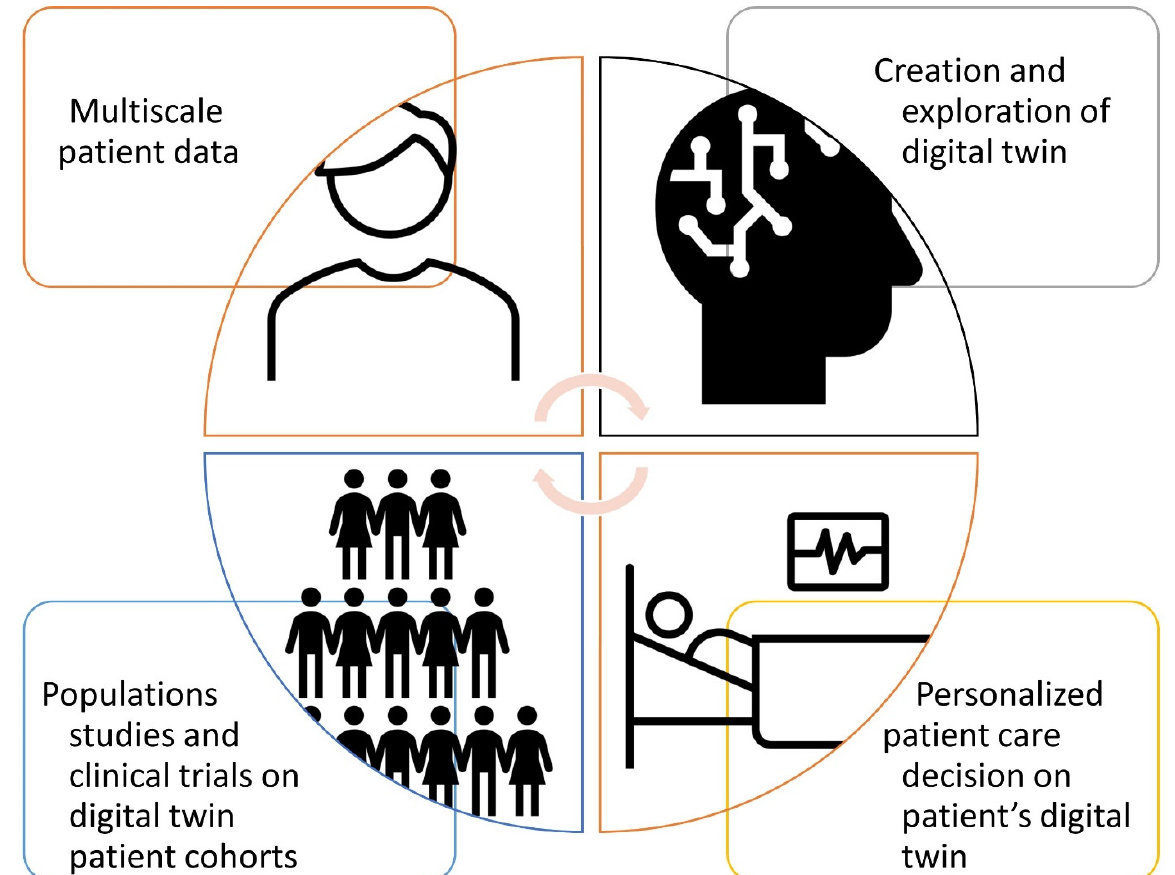
Figure 2. Key concepts and examples of patient digital twin life cycle.